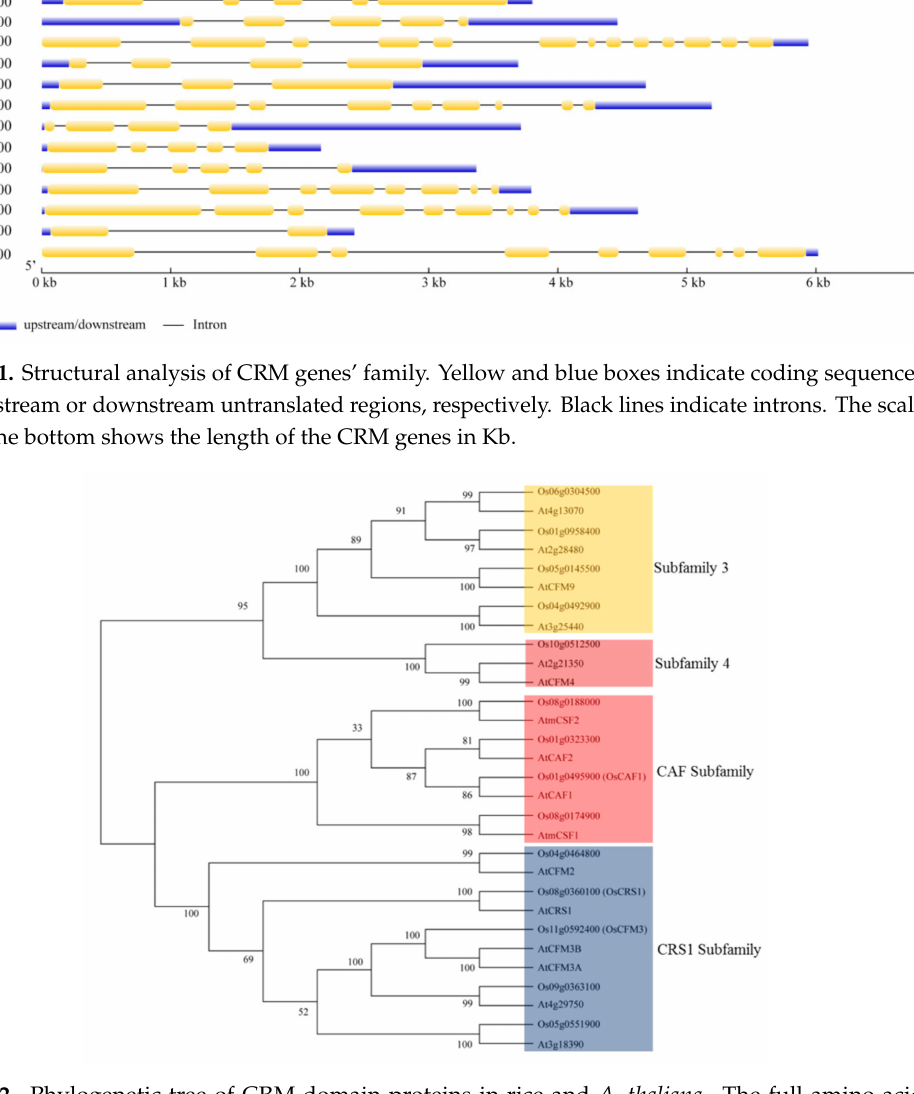
Figure 2. Phylogenetic tree of CRM domain proteins in rice and A. thaliana . The full amino acid sequences of the CRM domain proteins were aligned by MUSCLE and the neighbor-joining tree was constructed in MEGA